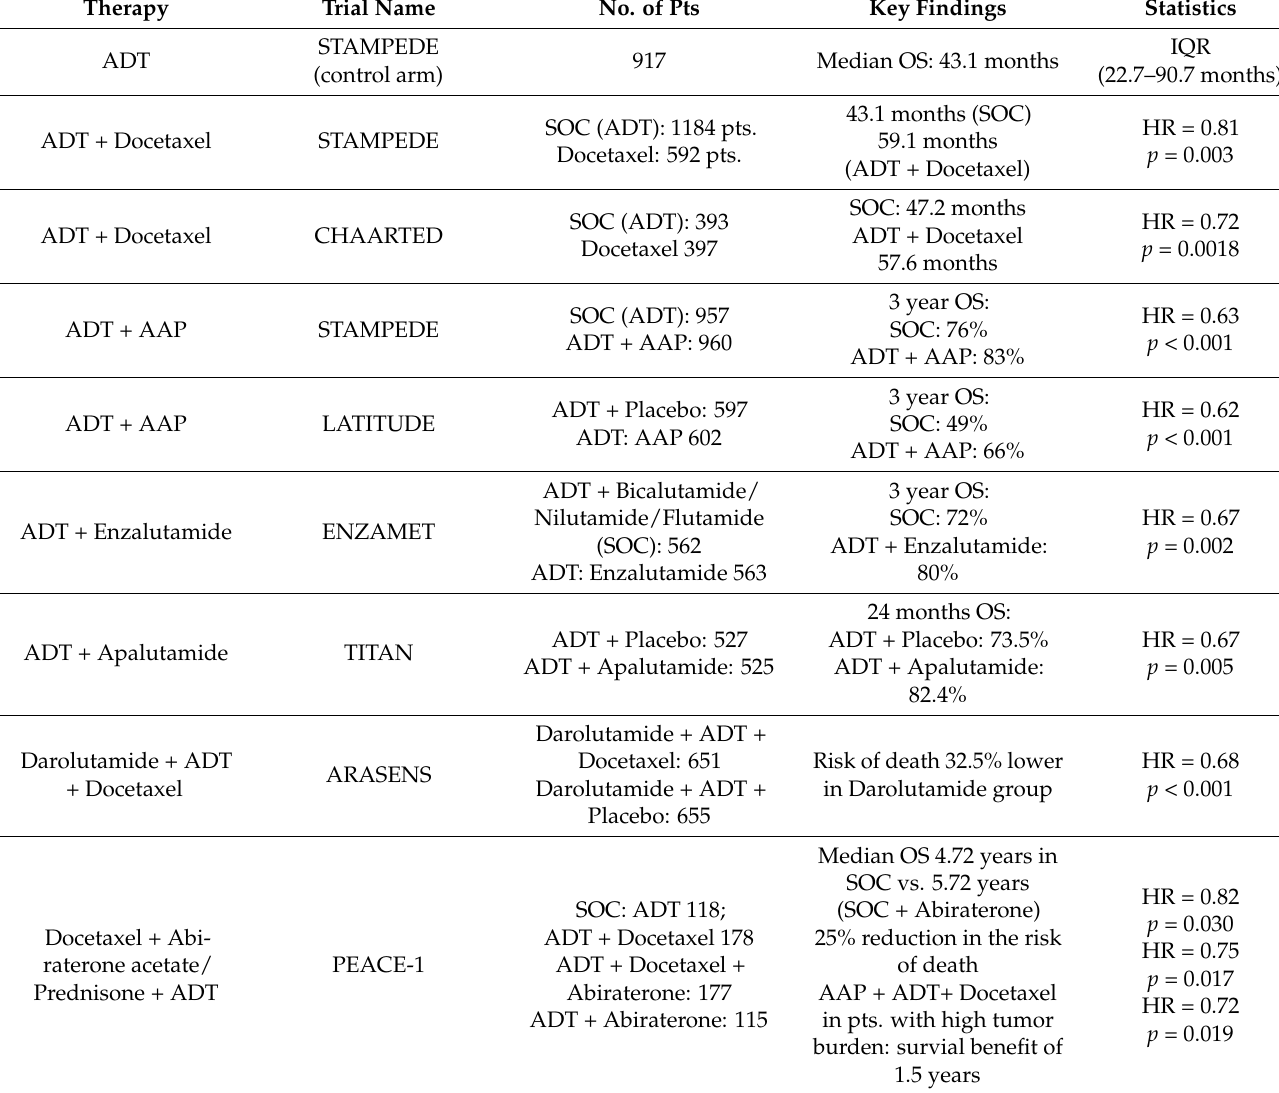
Table 3. List of treatment options and survival rates in